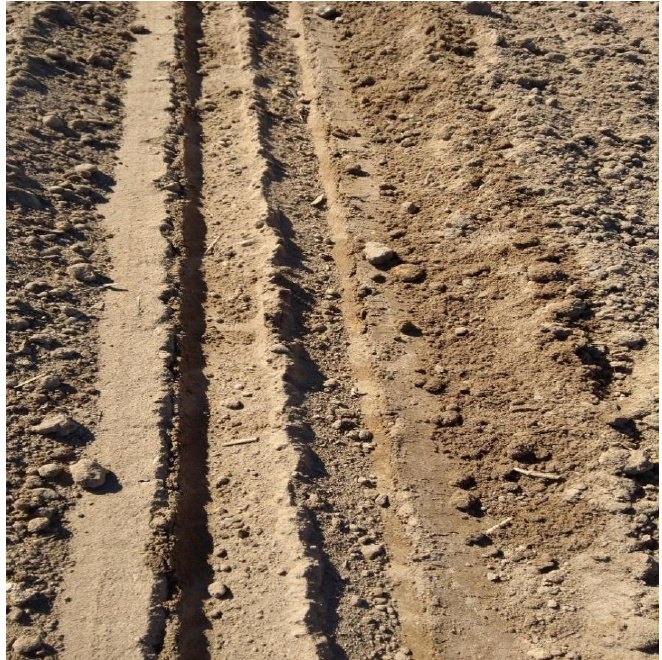
Figure 5. View of the field after placement. A trace of a seed coulter is visible on the left, and a fertilizer coulter on the right (10 cm from kernels, depth—5 cm) (photo taken by Szulc P.).